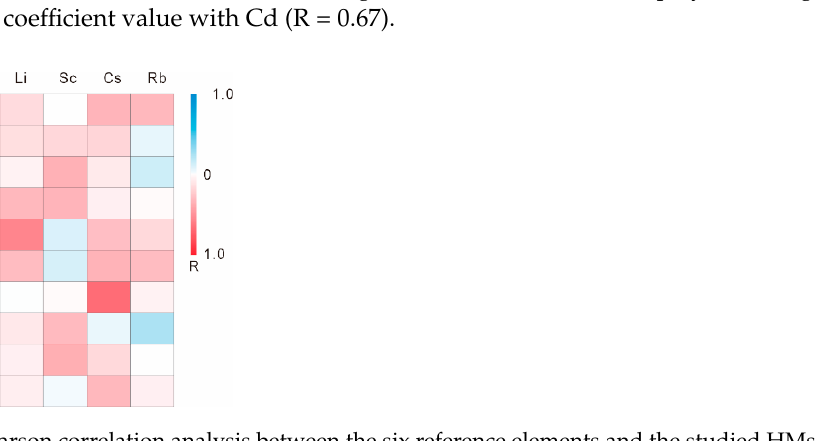
Figure 2. Pearson correlation analysis between the six reference elements and the studied HMs.